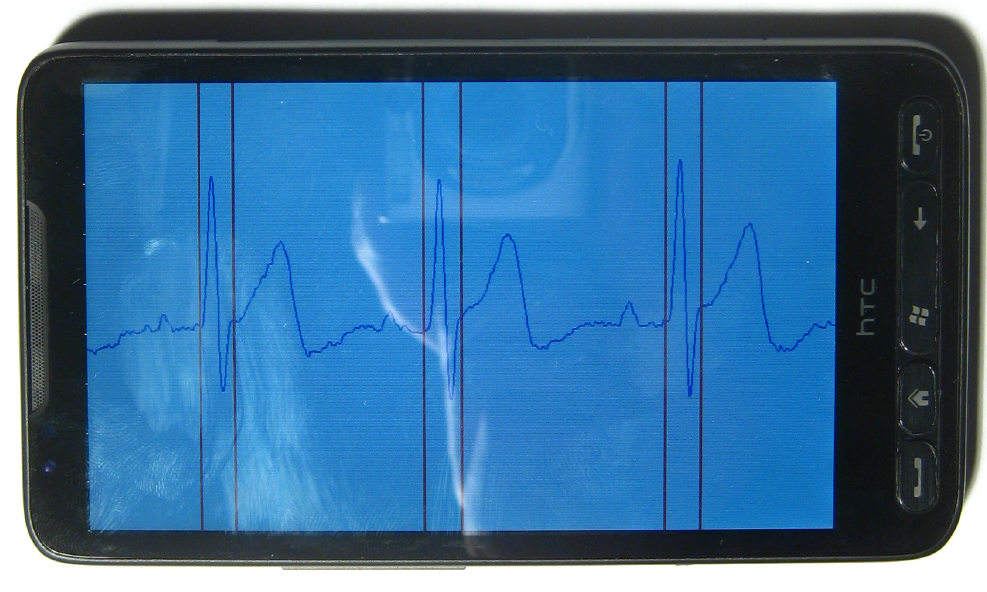
Figure 4. HTC HD2 collecting data from sensor